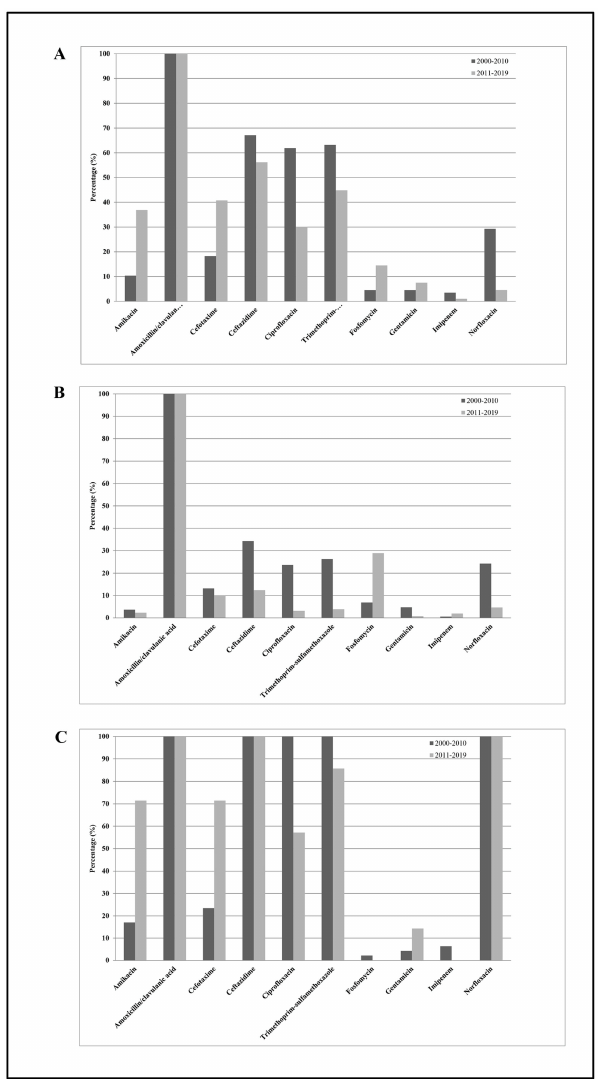
Figure 4. Distribution of mean antibiotic resistance percentages of K. aerogenes ( E. aerogenes ) iso- lates against the 10 antimicrobial agents tested, amikacin, amoxicillin/clavulanic acid, cefotaxime, ceftazidime, ciprofloxacin, norfloxacin, fosfomycin, gentamicin, imipenem, and